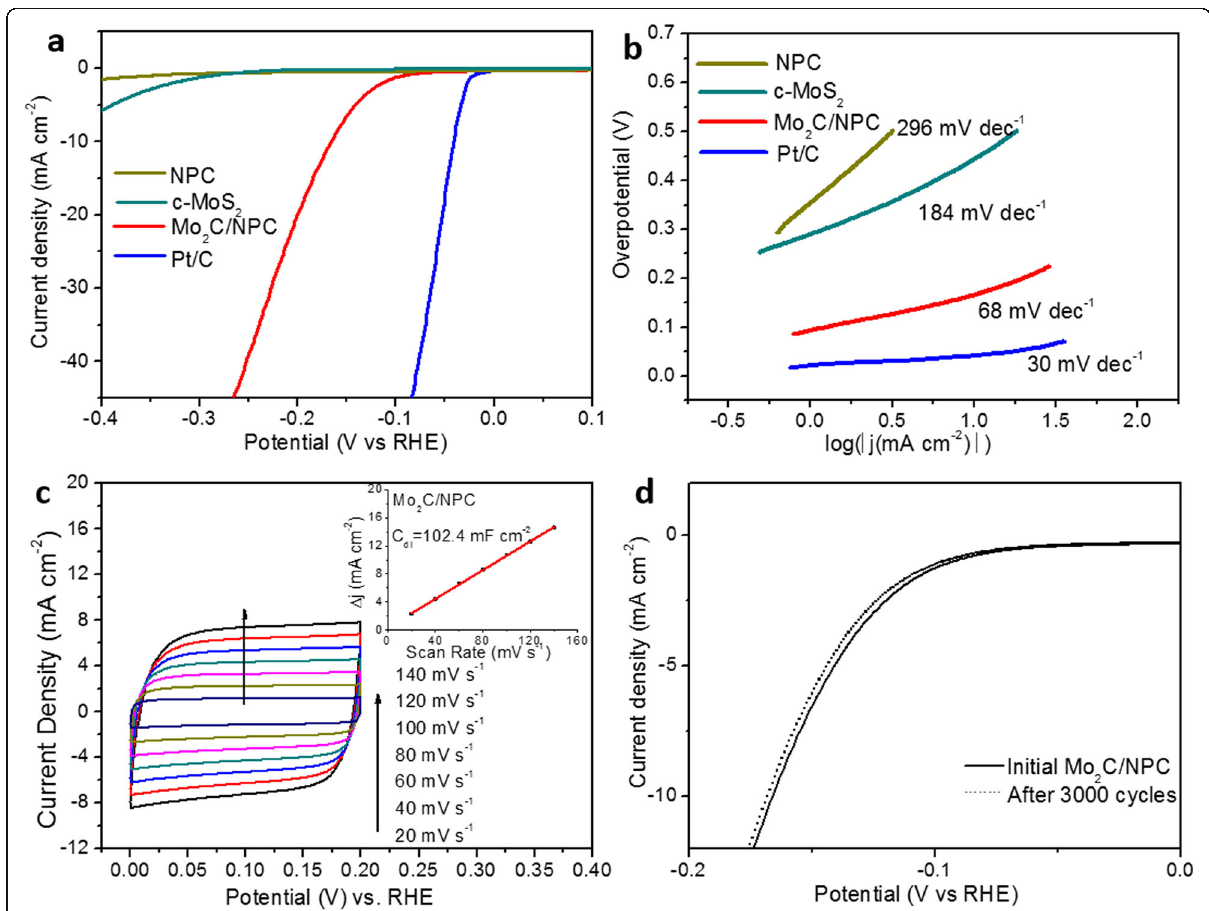
Fig. 5 Electrochemical measurements of Mo 2 C/NPC hybrid for HER electrocatalysis in 0.5 M H 2 SO 4 . a Polarization curves and b Tafel plots of Mo 2 C/NPC in comparison with Pt/C benchmark, c-MoS 2 , and NPC. c CV curves of Mo 2 C/NPC under different scan rates from 20 to 140 mV/s. The inset illustrates the plot of capacitive current at 0.1 V against the scan rate. d Polarization curves of Mo 2 C/NPC before and after 3000 potential